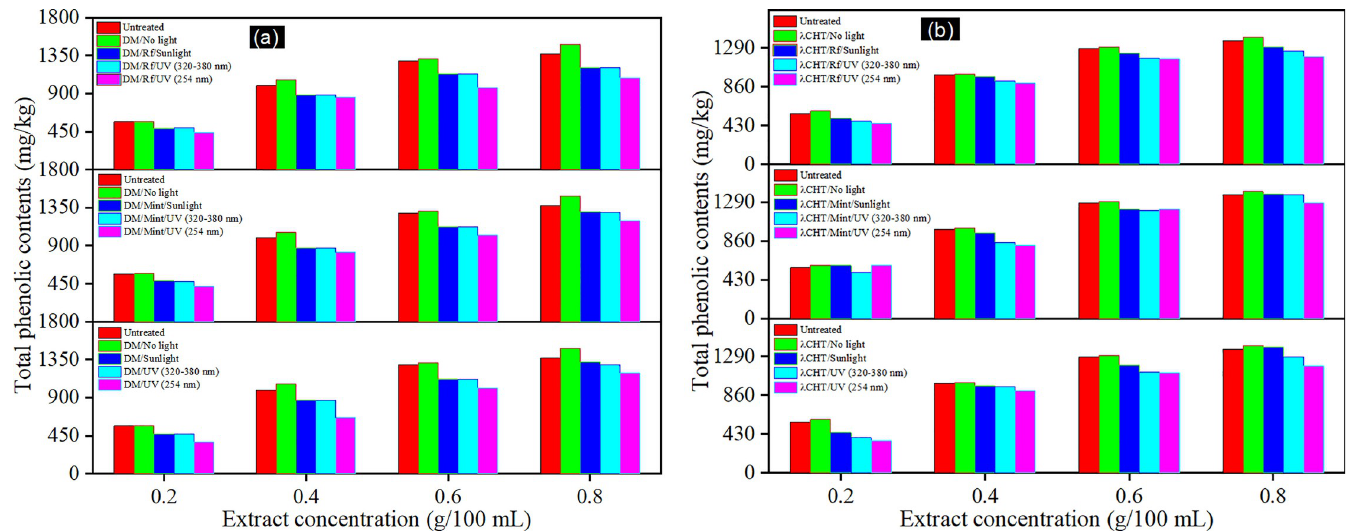
Fig 1. Effect of light and green photosensitizers on TPCs of cauliflower with and without pesticides i.e., (a) DM, (b) λ -CHT.